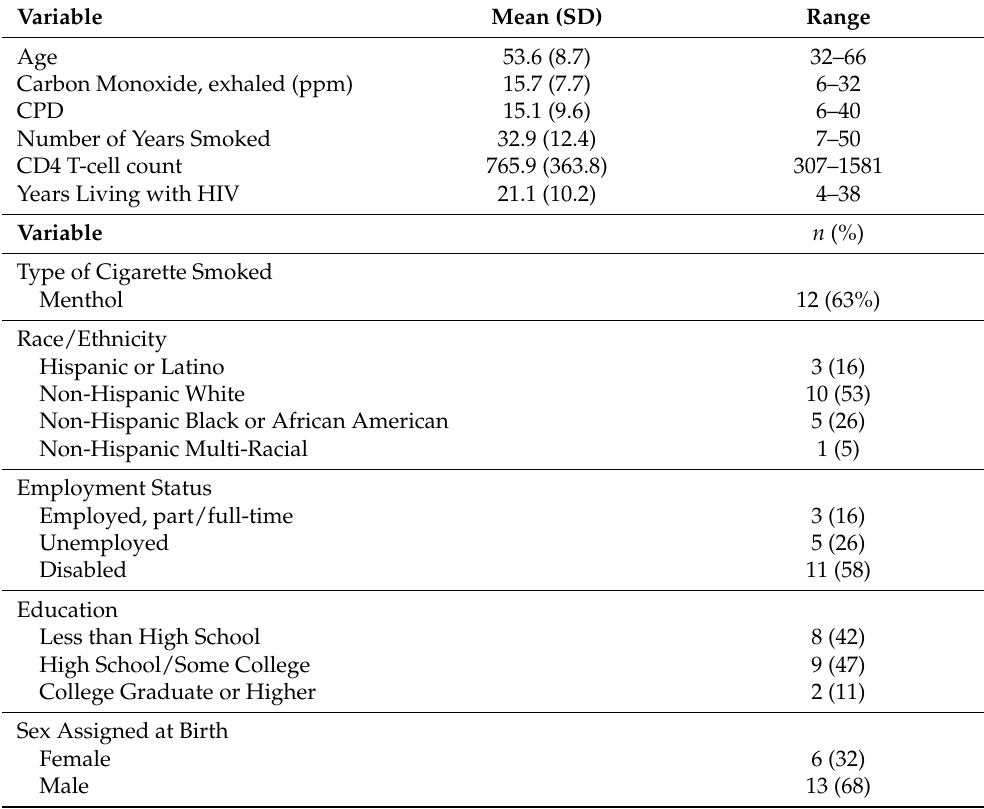
Table 1. Sample characteristics at baseline ( n = 19).